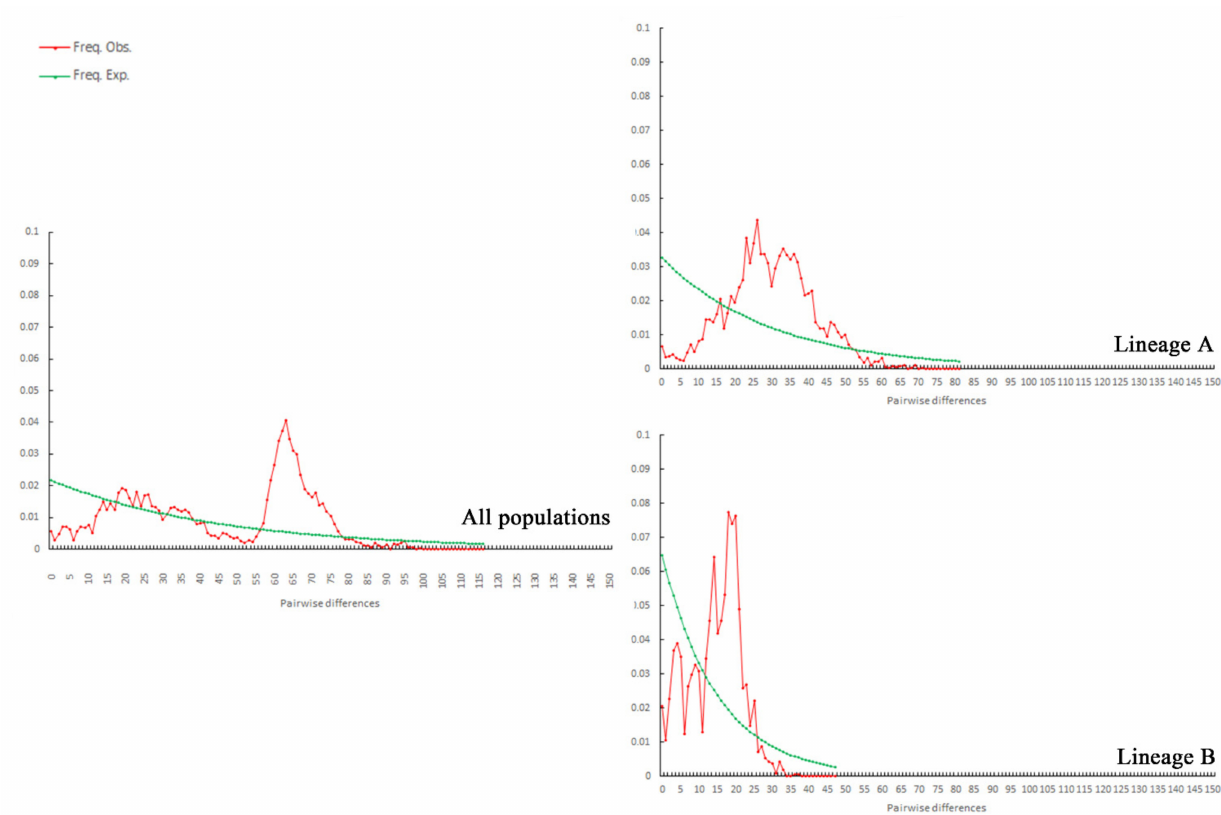
Figure 5. The observed pairwise differences and the expected mismatch distributions under the sudden expansion model of swimming crabs: all populations; lineage A; lineage